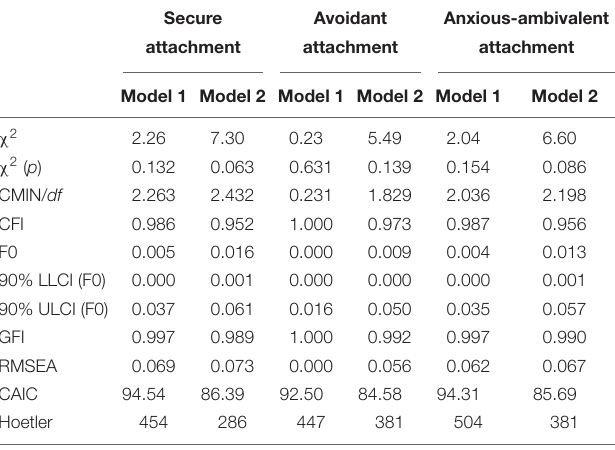
TABLE 4 | Model matching values (1, reference and 2, after the removal of two paths). Secure Avoidant Anxious-ambivalent attachment